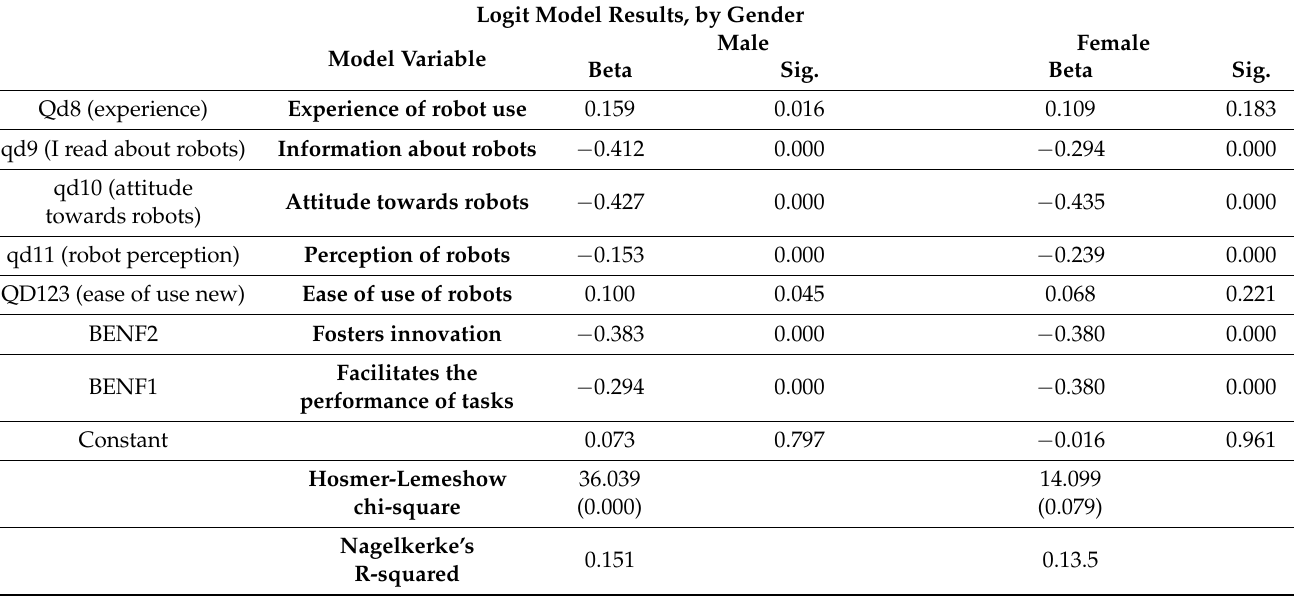
Table 5. Logit results model, by gender, age and educational level of the